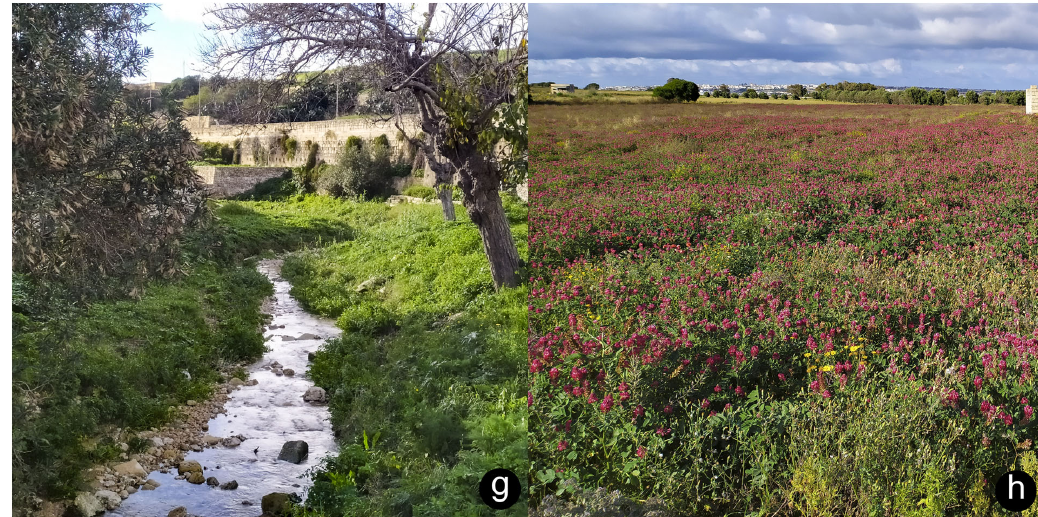
Figure 2. Sampled habitats in the Maltese Islands. ( a ) Semi ‐ natural woodland, Buskett; ( b ) mosaic of maquis and agricultural land, Buskett; ( c ) garigue/phrygana, Marfa, Mellie ħ a; ( d ) coastal cliff plateau with sandy soil and low ‐ growing vegetation, Mi ġ ra Fer ħ a, Rabat; ( e ) coastal clay slopes with steppe, Qarraba and Ġ nejna Bay, M ġ arr; ( f ) valley freshwater pool with loamy banks vegetated by